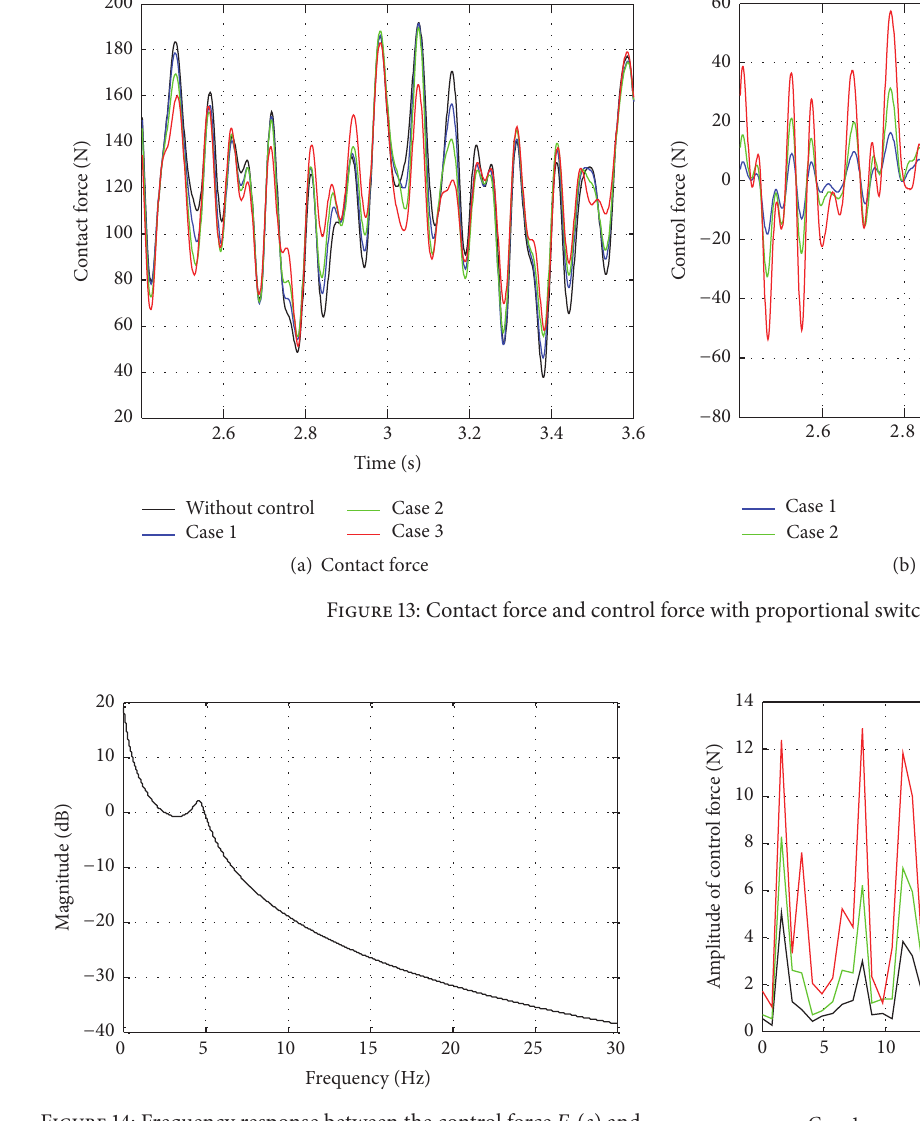
Figure 14: Frequency response between the control force 𝐹 𝑢 (𝑠) and contact force 𝐹 𝑐 (𝑠) .